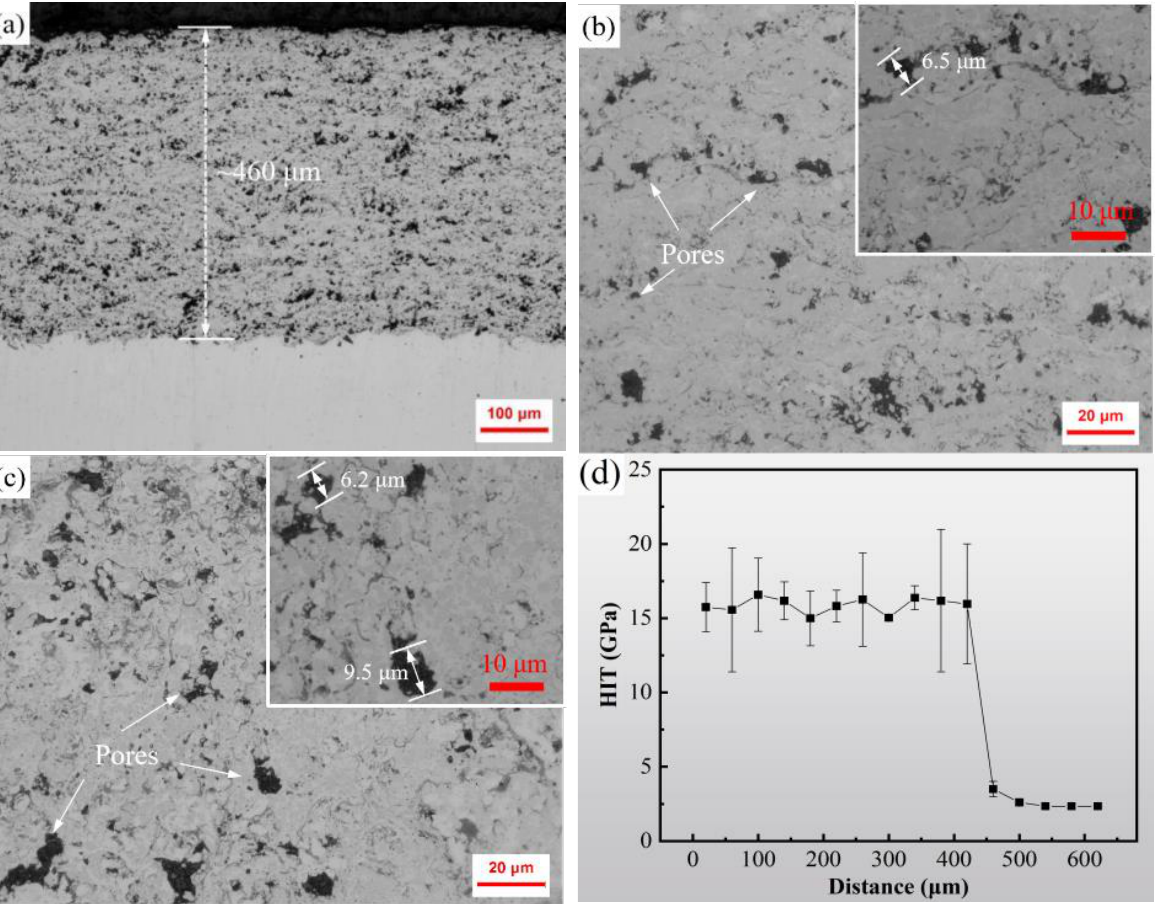
Figure 3. Microstructure and nano hardness of HVOF sprayed WC−Cr 3 C 2 −Ni coating: ( a , b ) the cross−section morphology; ( c ) surface topography; ( d ) nano hardness of cross−section .